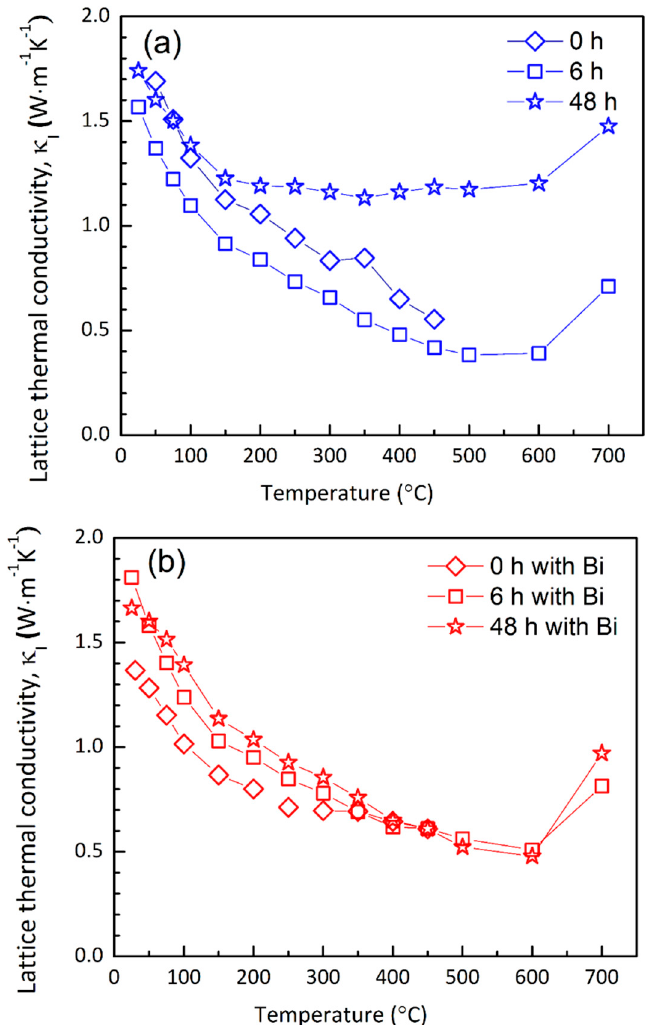
Figure 5. The temperature dependent lattice thermal conductivity values evaluated from the measured thermal and electrical conductivities applying the Wiedemann-Franz relationship for the hot-pressed (HP) series of specimens aged at 380 °C for 0 (diamonds), 6 (squares), and 48 h (stars), for the ( a ) Bi-free (blue symbols) and ( b ) Bi-alloyed (red symbols) materials.